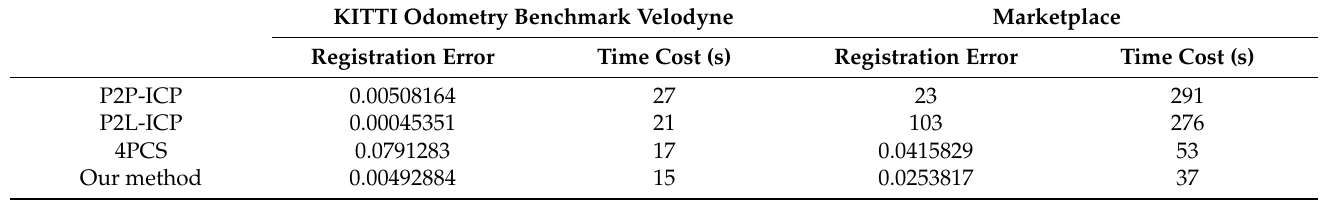
Table 5. Performance comparison in outdoor scenes.